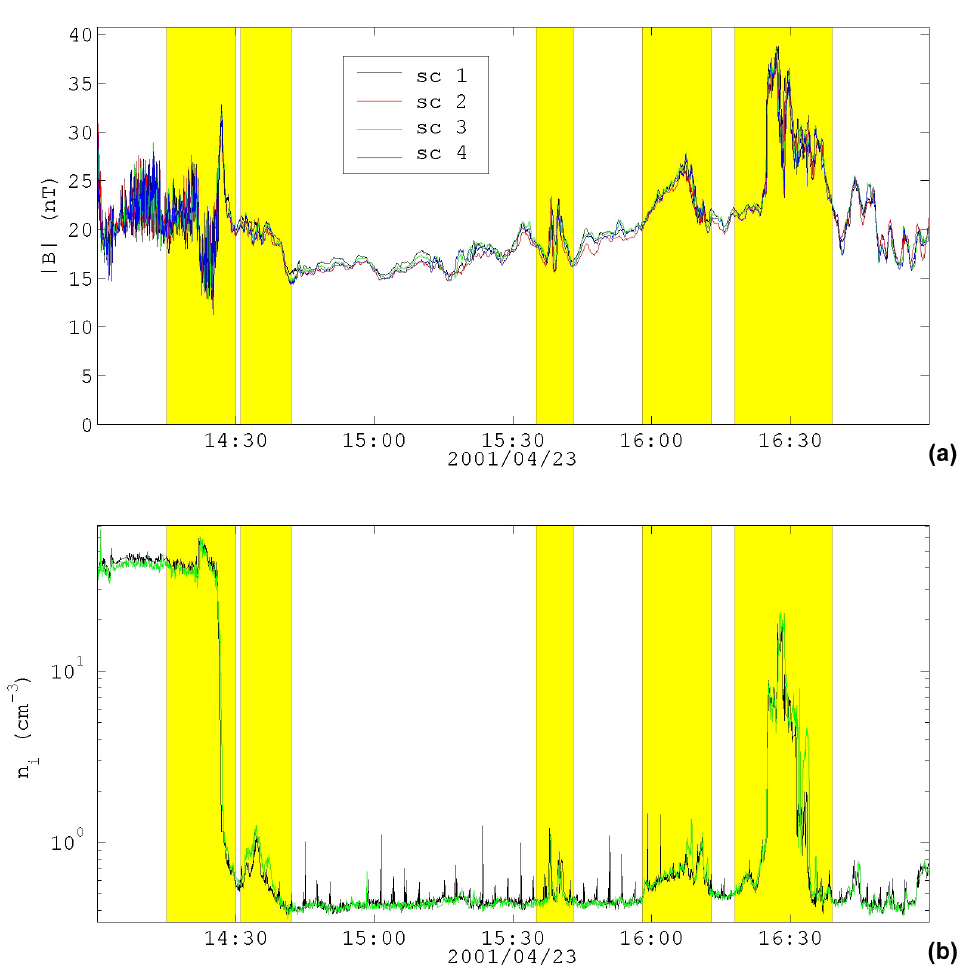
Fig. 1. Inbound pass by Cluster on 23 April 2001. The shaded areas identify the main magnetopause crossing and four subsequent transients. ( a ) Magnetic field strength (FGM). ( b ) Ion density